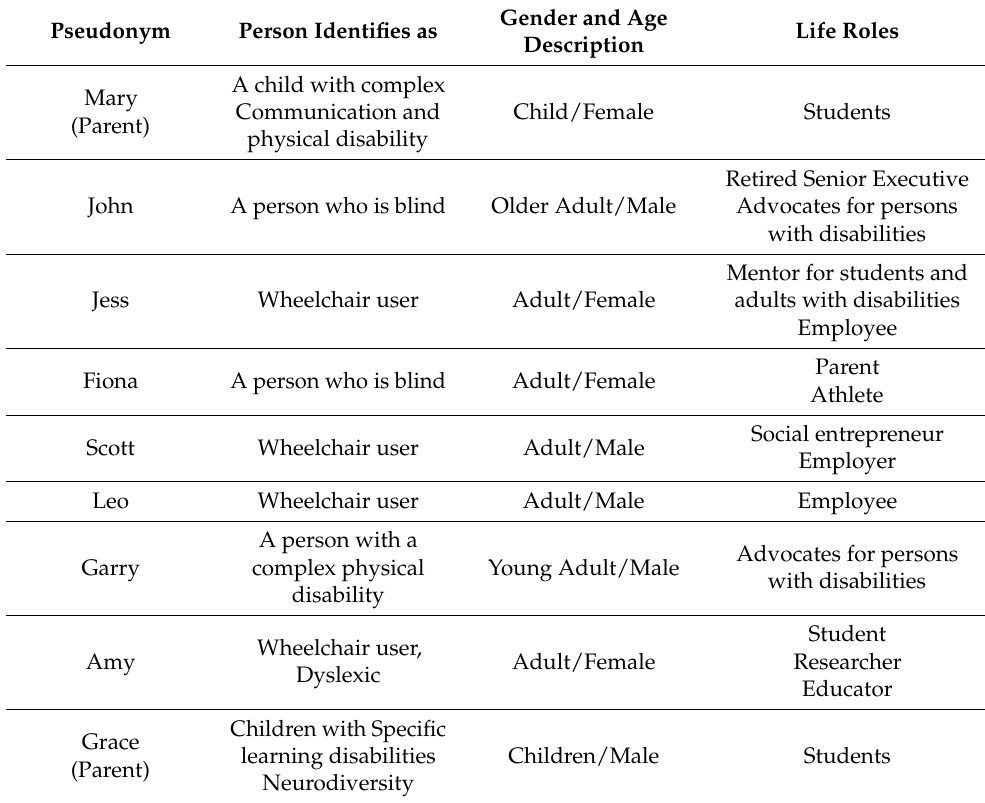
Table 1. Participants’ demographic